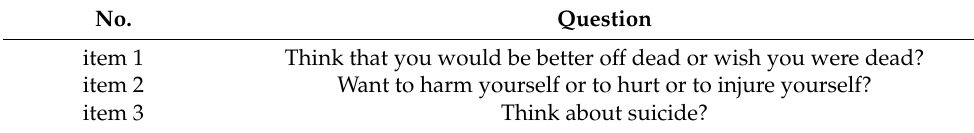
Table A1. MINI questions 1–3 items.